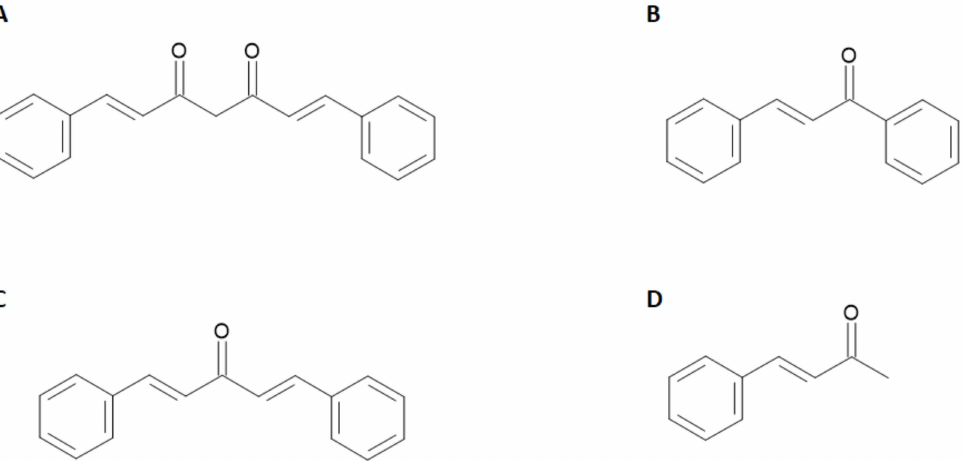
Figure 2. Curcuminod ( A ), chalcone ( B ), dibenzylideneacetone ( C ), and dehydrozingerone ( D ) general structure. Substituents on the aromatic rings provide the specific